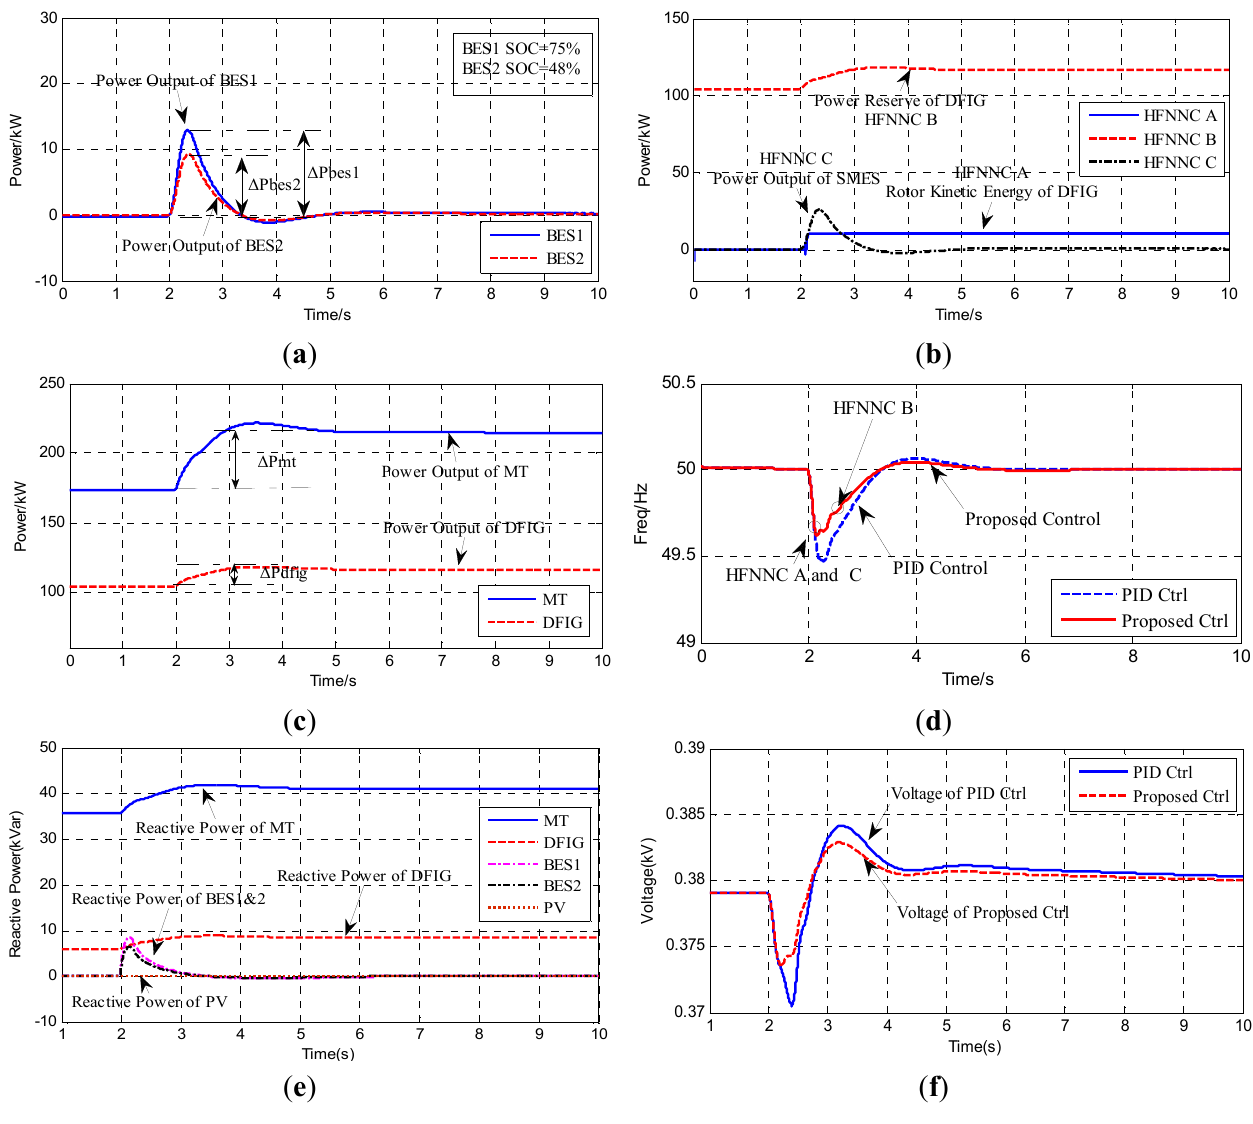
Figure 8. Control performance with the proposed control in case A. ( a ) Active power outputs of BESs by SOC control; ( b ) Active power outputs of DFIG-SMES by HFNNC contro; ( c ) Active power outputs of DGs; ( d ) Frequency responses of different control methods; ( e ) Reactive power outputs of DERs; ( f ) Voltage responses of different control